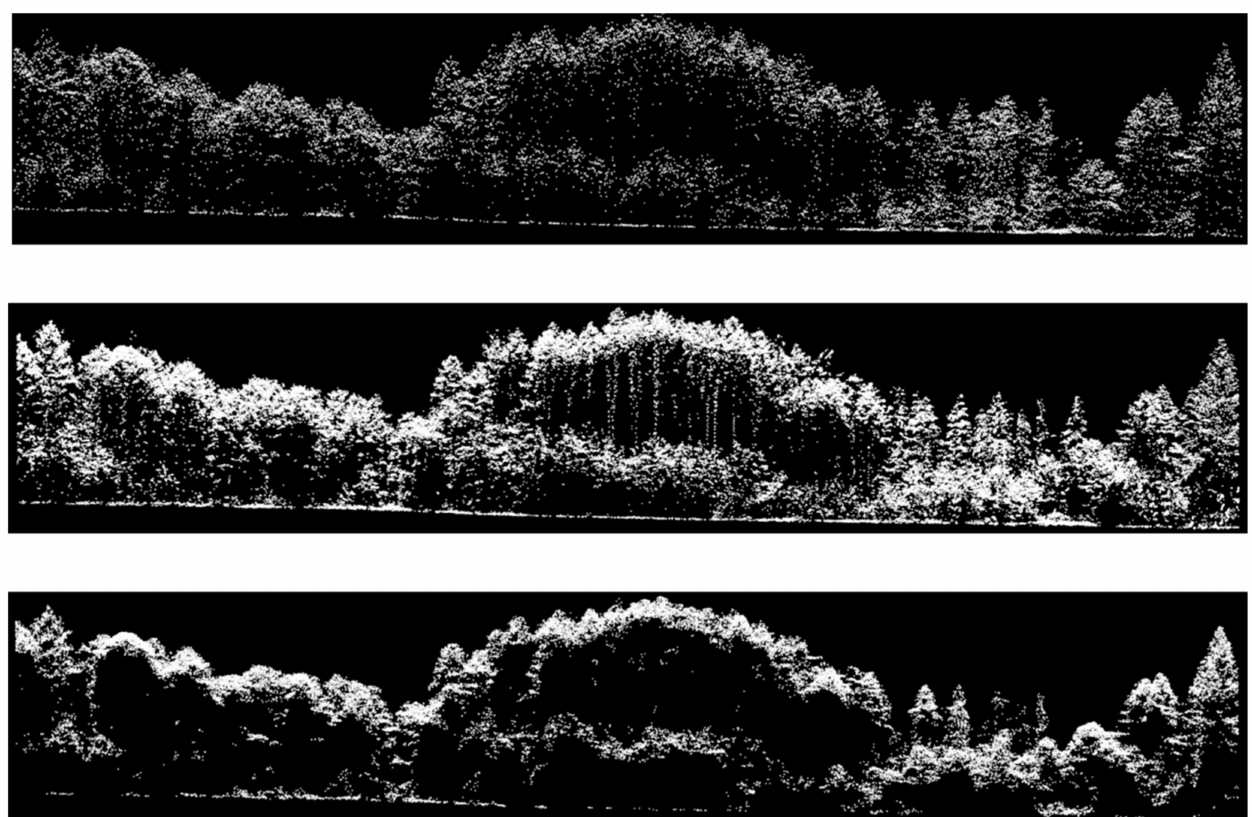
Figure 2. Transect extracted from the three lidar datasets: ( top ) monospectral ALS (ALS12); ( middle ) multispectral ALS (MSL16), with the three channels combined; and ( bottom ) photon-counting lidar